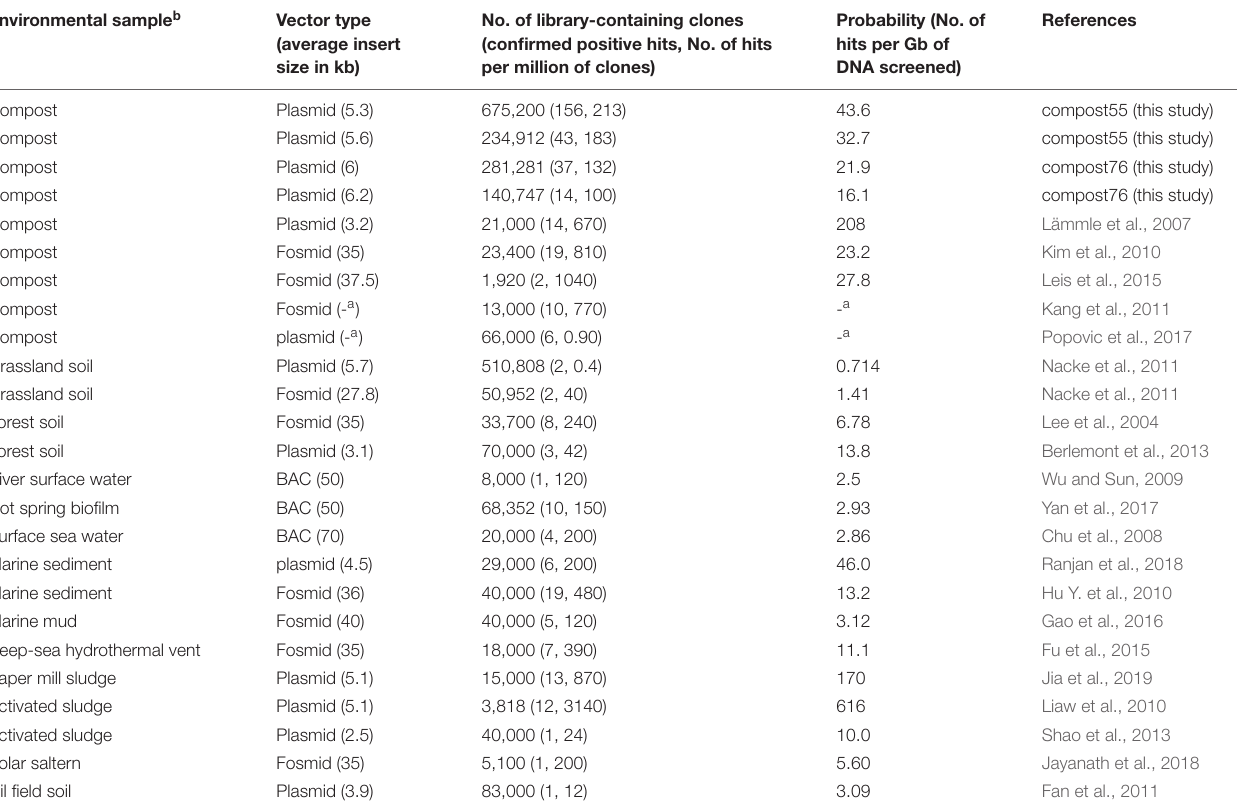
TABLE 1 | Summary of metagenomic libraries used for lipolytic activity screening in this and other